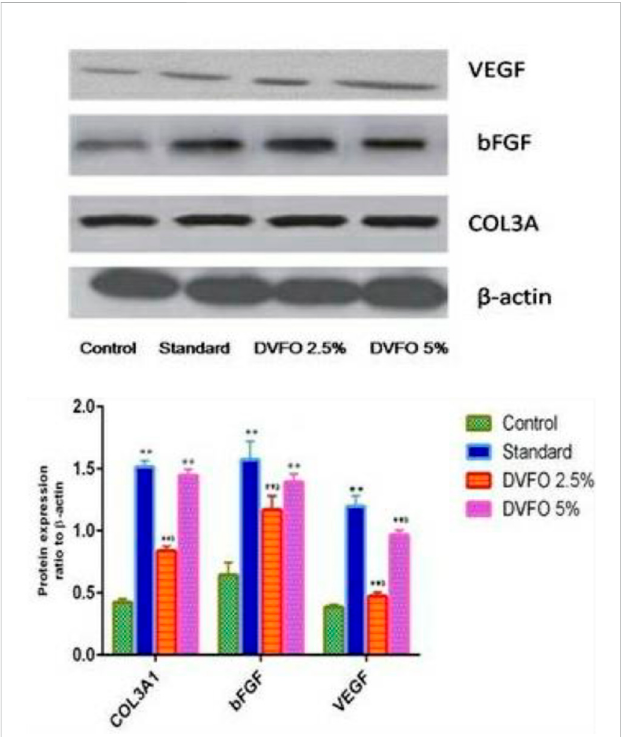
FIGURE 8 Histological evaluation of wound skin sections stained with Masson ’ s trichome (Bar = 1000 μ m). (A) Normal skin, (B) Wound control group, (C) Standard treatment group, (D) 2.5% w/w DVFO treatment group, (E) 5% w/w DVFO treatment group.